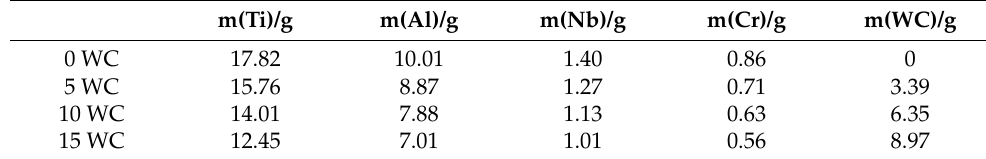
Table 1. Nominal elemental contents for the 0 WC to 15 WC powders.